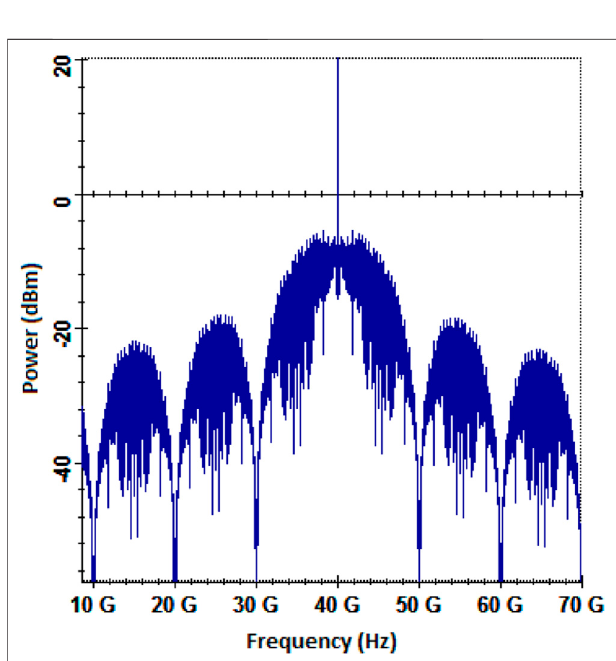
FIGURE 5 | Measured Upconverted 40 GHz radio carrier.